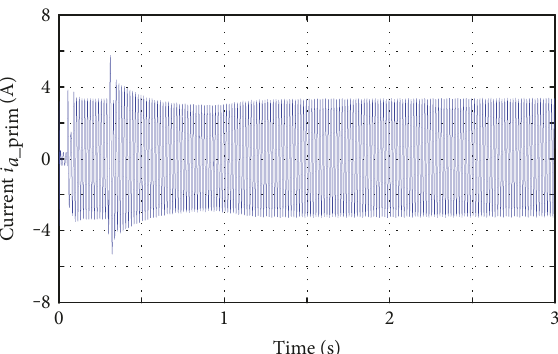
Figure 22: Three-phase currents fl owing in the